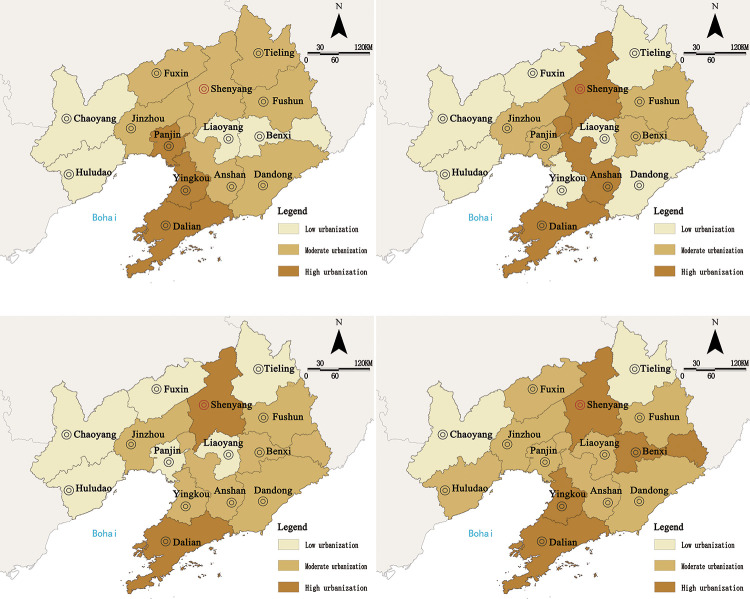
The spatial distribution of urban subsystem quality in Liaoning Province from 2009 to 2019.a. Population urbanization. b. Economic urbanization. c. Social urbanization. d. Land urbanization. (Source of base map: the open source map data service provided by the National Platform for Common GeoSpatial Information Services (https://www.tianditu.gov.cn/)).